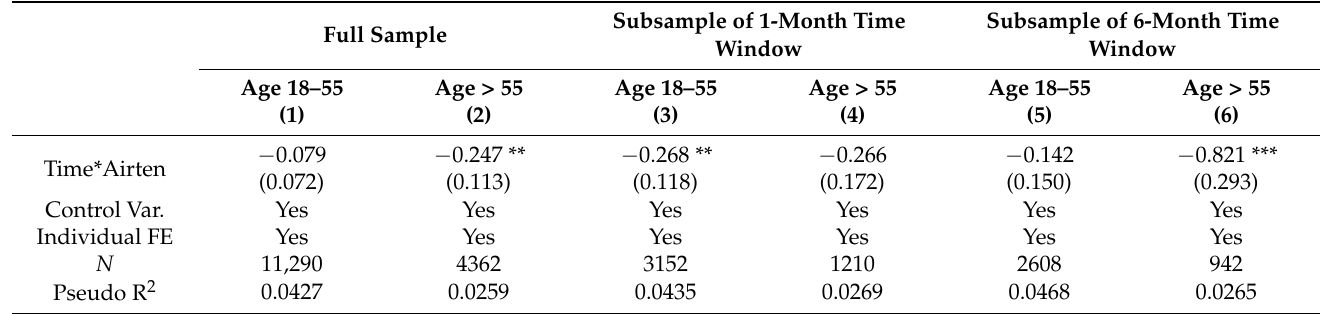
Table 7. Ordinal logistic results of heterogeneity analysis of different ages. Full